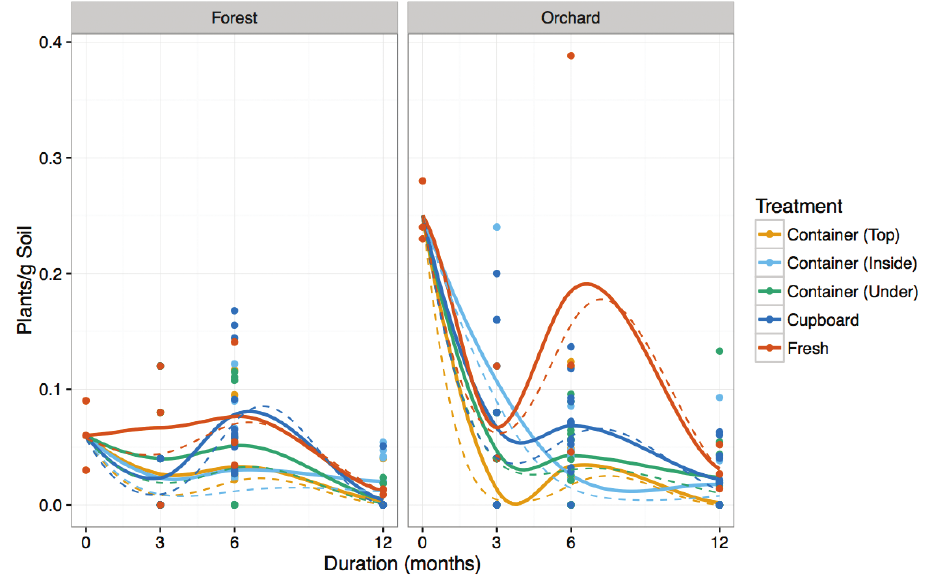
Figure 6. Scatterplot showing changes in mean plants/g soil grown from soil collected at 0, 3, 6 and 12 months recovered from on, in and under four sea containers and inside four cupboards. Solid lines show the smoothed means and dashed lines predictions from the preferred